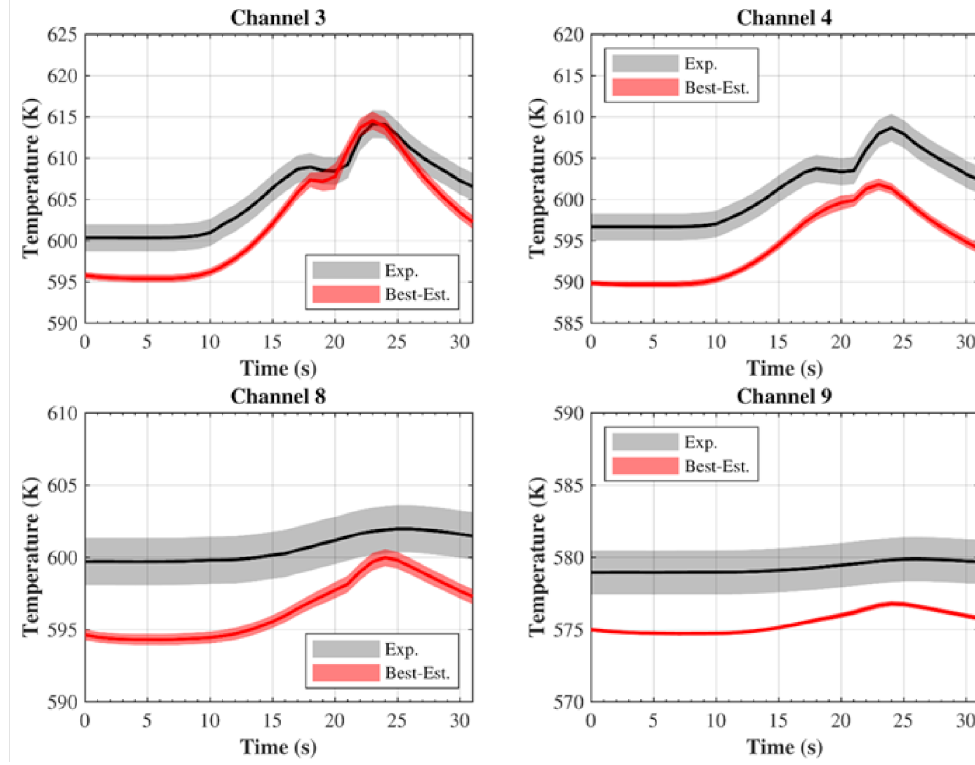
Figure 12. Outlet coolant temperature—300 kW/m 2 , 0% valve opening scenario with the sensitivity matrix recalculated.